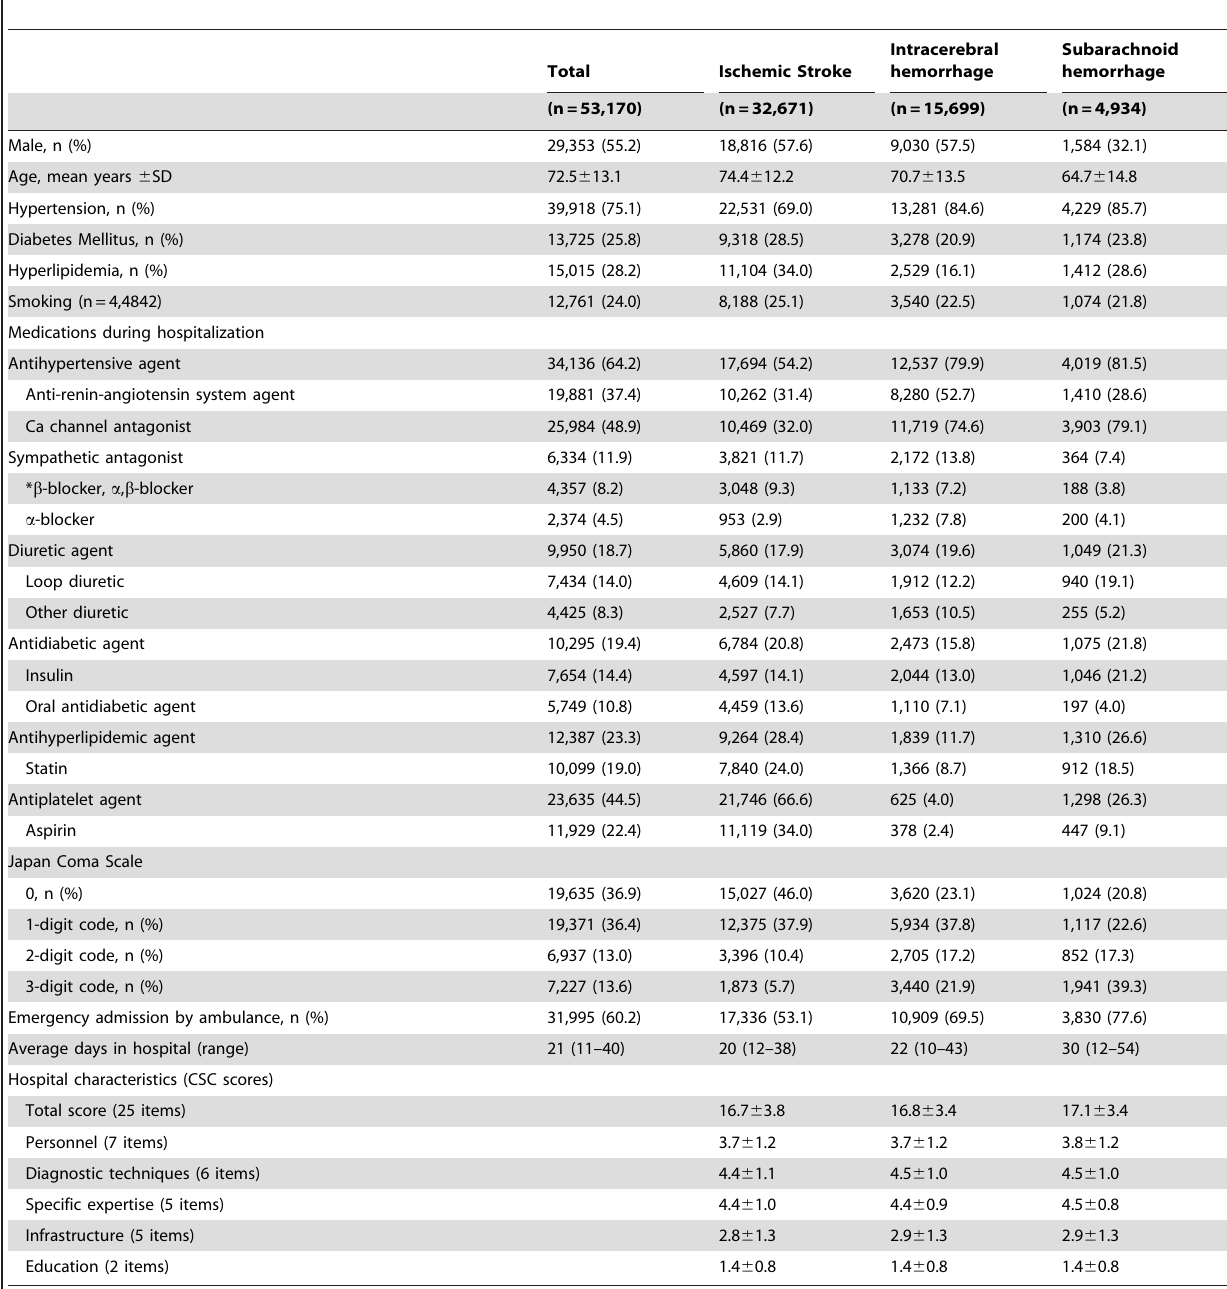
Table 3. Demographics of the patient study cohort at the time of diagnosis and hospital characteristics according to stroke type.